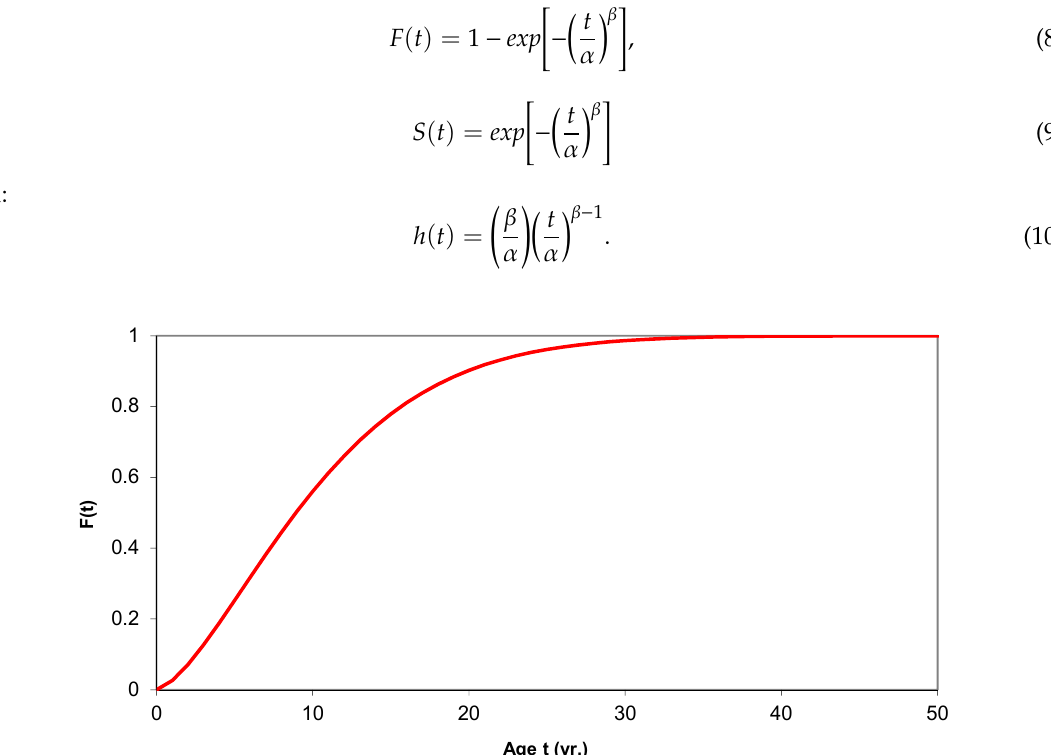
Figure 7. Cumulative distribution function for CAV element deterioration.